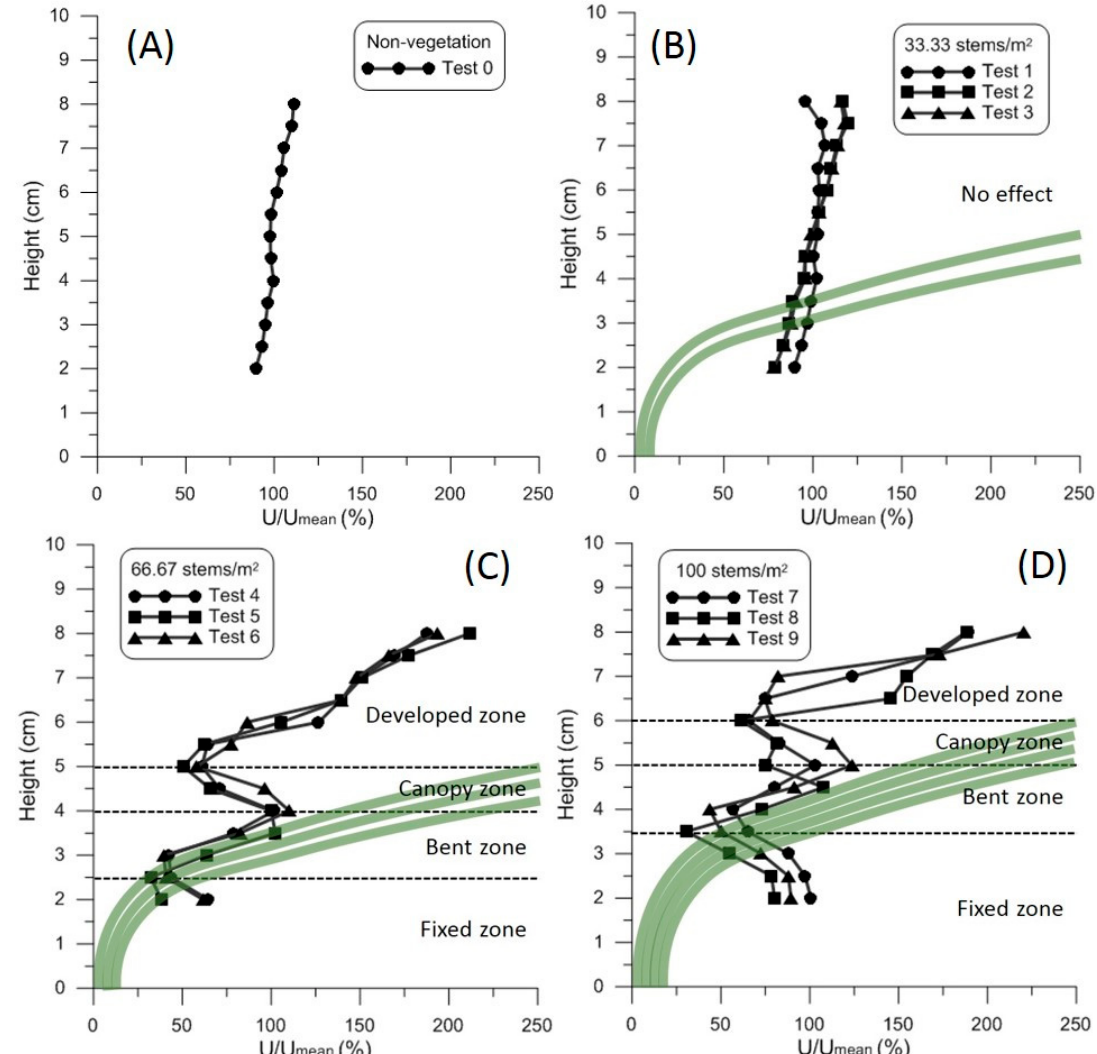
Figure 8. The relationship between the vertical velocity profile and vegetation elements in each vegetation density experiment. ( A ) is no vegetation test, ( B ) is 33.33 stems/m 2 test, ( C ) is 66.67 stems/m 2 test, ( D ) is 100 stems/m 2 test.